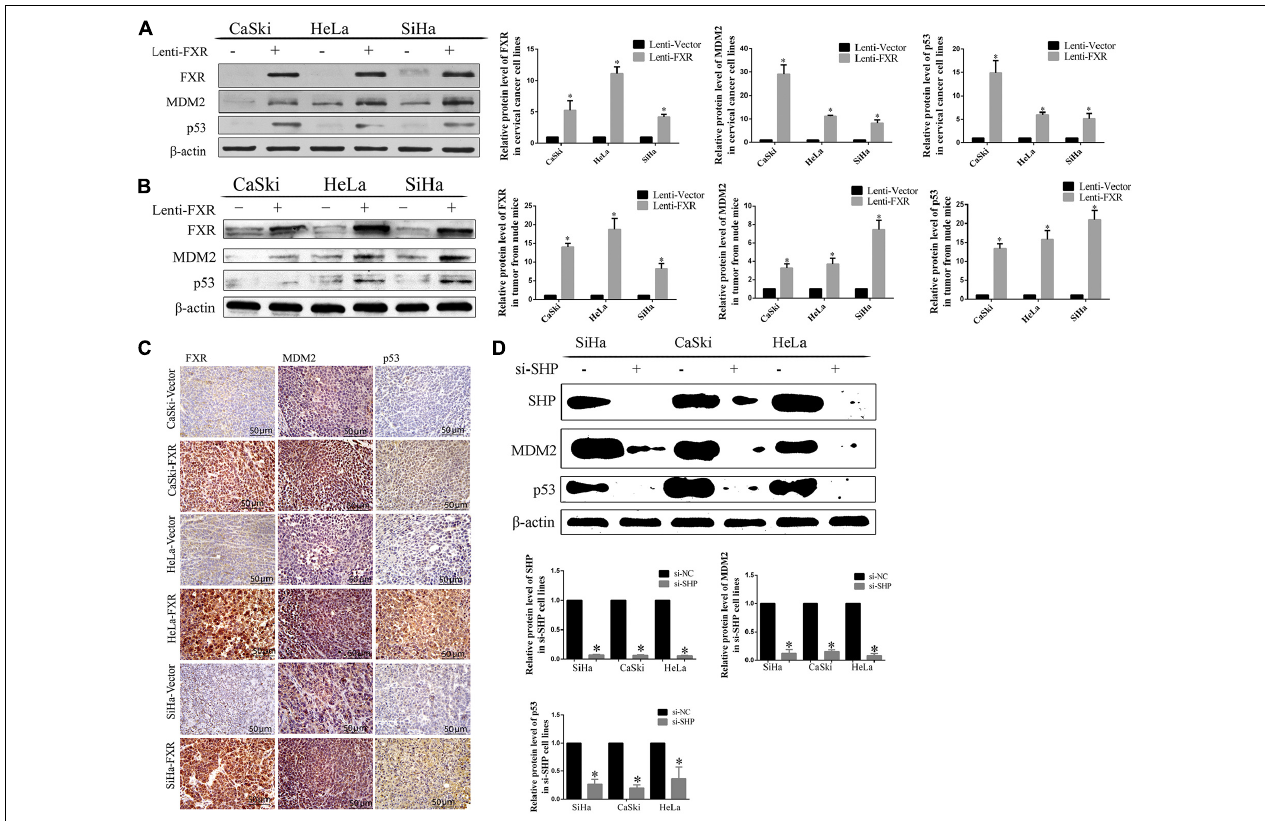
FIGURE 6 | Correlation between FXR and SHP/p53 expression. Overexpression of FXR upregulated MDM2 and p53 in cervical cancer cells (A) and xenograft tumors from nude mice, as measured by western blot (B) and immunohistochemistry (C) . ∗ P < 0.05 vs. Lenti-Vector group. The knockdown of SHP decreased the protein levels of MDM2 and p53 (D) . ∗ P < 0.05 vs. si-NC